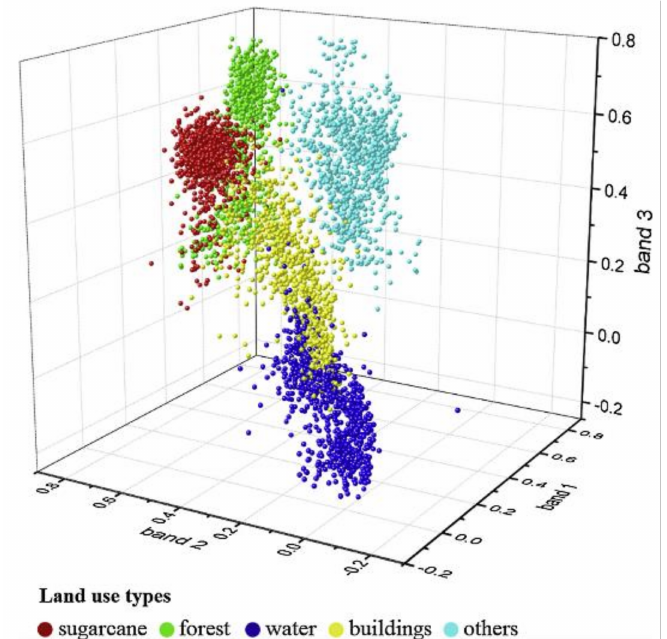
Figure 20. 3-dimensional space for visualization generated by Wang et al. [35]. The 3-band NDVI shows clear clusters for different land use classes, representative for different phenological stages (germination, grand growth and ripening) of